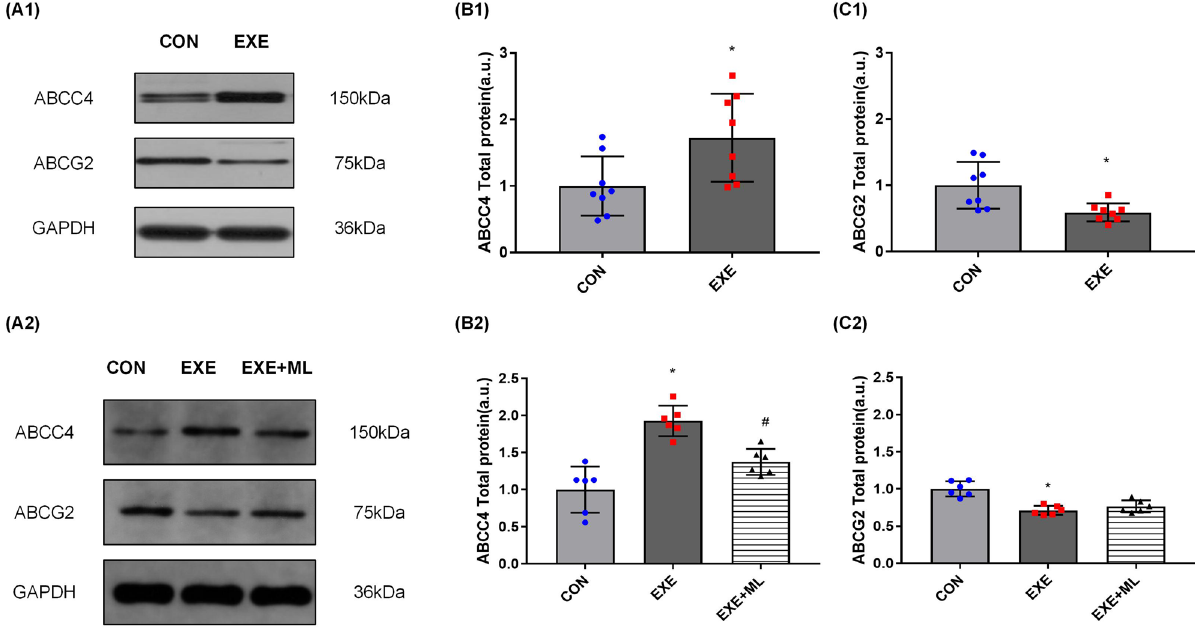
Figure 3. ( A1 – C1 ): ABCC4 and ABCG2 protein expression, normalized against GAPDH, in rat’s kidney. Data are means ± SD (n = 8). * Significantly different from CON ( p < 0.05). ( A2 – C2 ): ABCC4 and ABCG2 protein expression, normalized against GAPDH, in NRK-52E cells 24 h after exposure to 10% serum without exercise (CON), serum with exercise (EXE) or serum with exercise supplemented with ML385. Data are means ± SD (n = 6). * Significantly different from CON ( p < 0.05), # Significantly different from EXE ( p < 0.05).